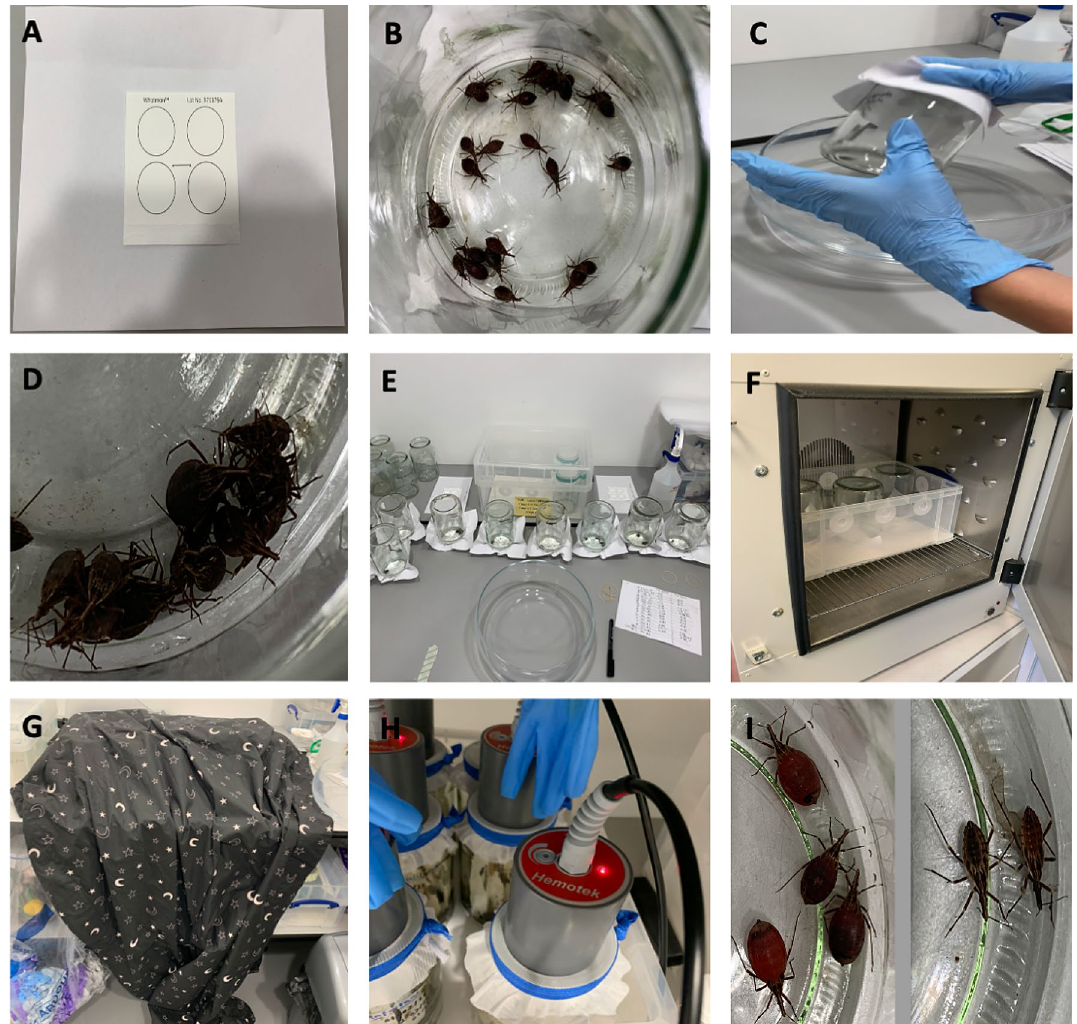
Figure 5. Photos of experimental set-ups. ( A ) QIAcard FTA classic card, stapled to plain A4 paper, to be secured over a glass jar opening with an elastic band; ( B ) bug number experiment with 25 blood-fed 3rd/4th instar R. prolixus ; ( C ) process to invert glass jars; ( D ) aggregating behaviour of 3rd/4th instar R. prolixus ; ( E ) time point assay experiment; ( F ) temperature experiment with incubator set to 32 °C for 24 h; ( G ) darkness experiment with blackout blanket over inverted jars; ( H ) blood-feeding the triatomines with Hemotek feeder using equine blood; ( I ) appearance of fed (left) vs. unfed bugs (right) in feeding status Triatomine number. After blood-feeding 93 3rd/4th instar R. prolixus and placing the following numbers in each glass jar: 1, 5 and 25 (Figs. 2 and 5B,D,H), the jars were inverted onto FTA cards for 24 h. After this time, bugs were returned to the colony and FTA cards stored at − 20 °C. Temperature. After blood-feeding 45 3rd/4th instar R. prolixus and placing 5 in each glass jar, the jars were inverted onto FTA cards for 24 h. Each of the jars were placed in different temperatures in incubators for this duration: 21 °C, 27 °C, and 32 °C (Figs. 2 and 5F). After 24 h, bugs were returned to the colony and the FTA cards stored at − 20 °C. Feeding status. Fifteen 3rd/4th instar R. prolixus that had not blood-fed for 19 weeks were removed from the colony and 5 placed into each jar. An FTA card was secured to the opening and the jar inverted, and the bugs left for 24 h. The same was done with 15 3rd/4th instar R. prolixus which had been fed just before the FTA card was secured to the jar (Figs. 2 and 5H,I). After 24 h, bugs were returned to the colony and the FTA cards were stored at − 20 °C. Degradation at ambient temperature. After blood-feeding 105 3rd/4th instar R. prolixus and placing 5 in each jar, the jars were inverted onto FTA card for 24 h. After this point, bugs were returned to the colony and FTA cards detached from jars and left at room temperature for the following time points: 24 h, 48 h, 72 h, 1 week,